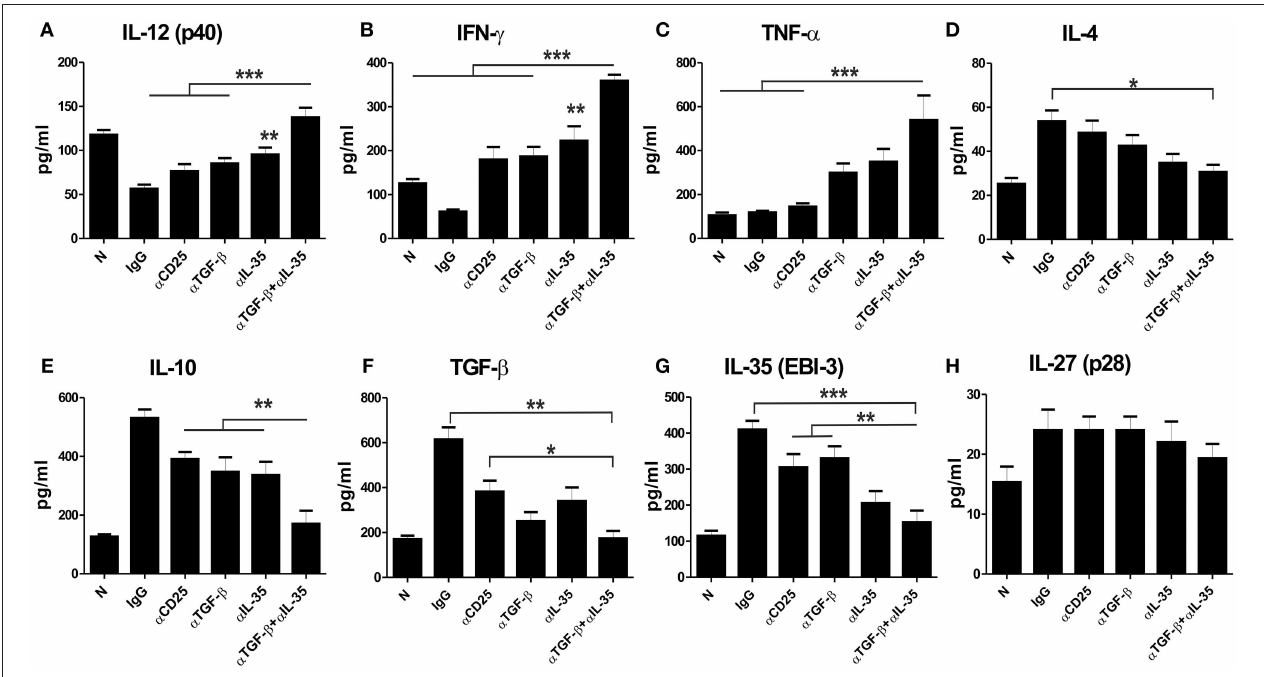
FIGURE 6 | Cytokine responses post administration of neutralizing antibodies in the infected mice. LAg stimulated splenocytes of naive and infected mice were treated with neutralizing mAbs (as described in Materials and Methods) and cultured for 72h. Culture supernatants were used for measuring IL-12 (p40) (A) , IFN- γ (B) , TNF- α (C) , IL-4 (D) , IL-10 (E) , TGF- β (F) , EBI-3 (G) and IL-27 (p28) (H) through Cytometric Beads Assay (CBA). Data expressed as means ± SE for five mice per group are representative of two independent experiments with similar results. * P < 0.05; ** P < 0.01; *** P < 0.001 as assessed by one-way ANOVA and Tukey’s multiple comparison